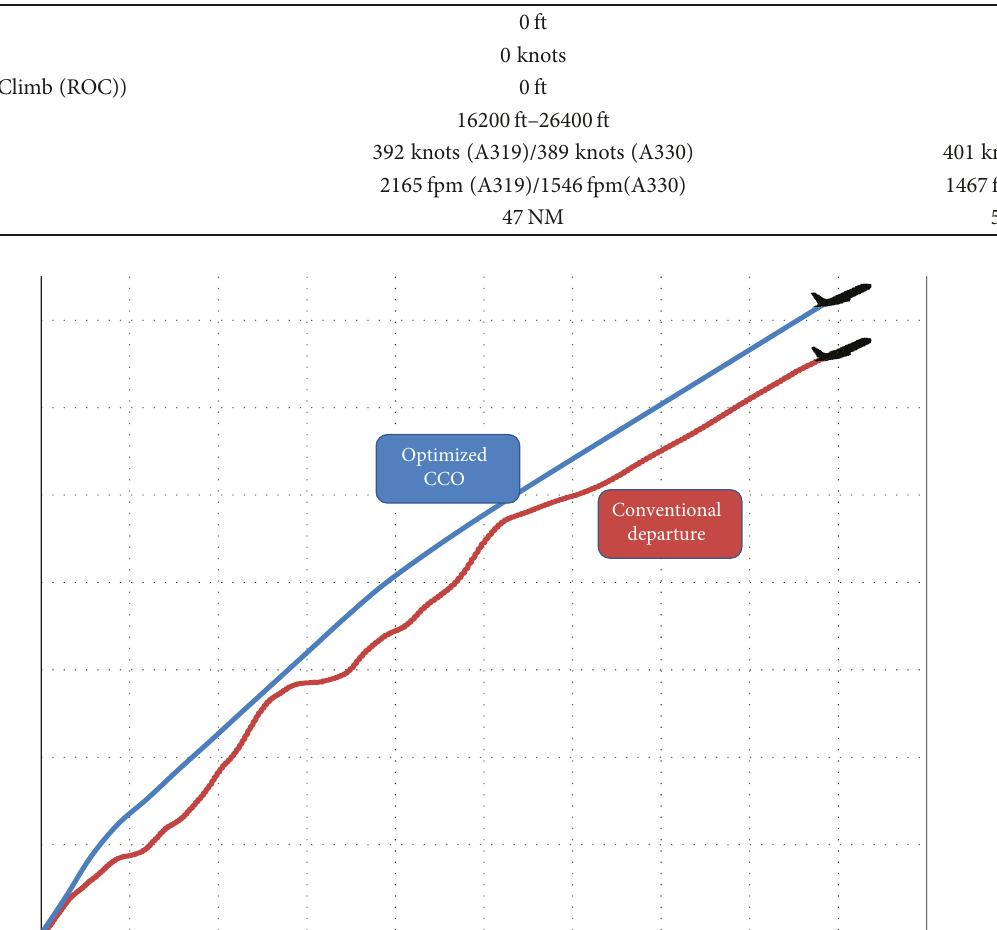
Figure 2: Departure fl ight paths. Optimized CCO versus standard